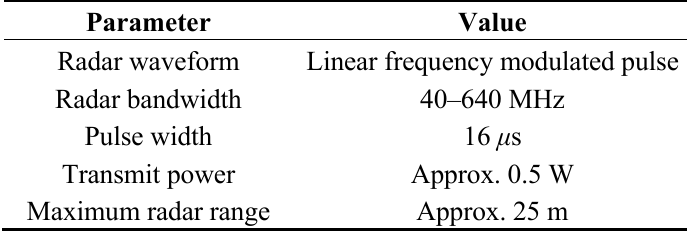
Table 1. Radar system